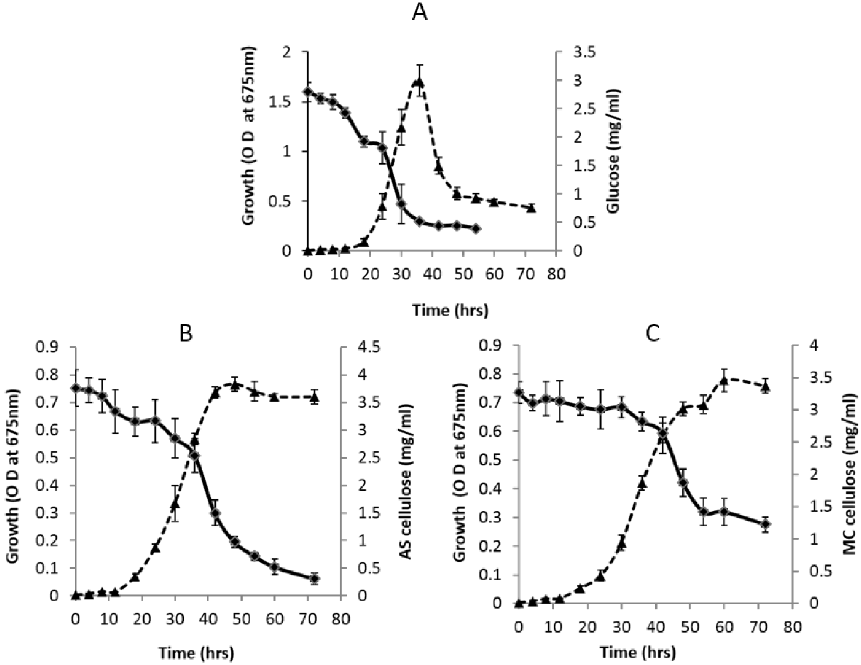
Fig 2. Growth and substrate consumption profile of F . succinogenes S85: A) Glucose B) Acid swollen (AS) cellulose and C) Microcrystalline (MC) cellulose ( ♦ represents substrate utilisation and ▲ represents OD 675